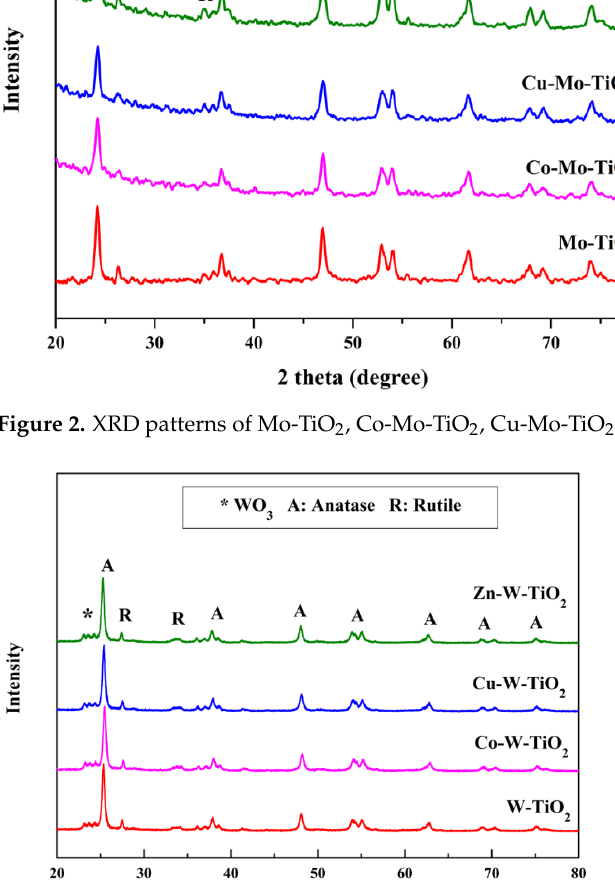
Figure 3. XRD patterns of W ‐ TiO 2 , Co ‐ W ‐ TiO 2 , Cu ‐ W ‐ TiO 2 , and Zn ‐ W ‐ TiO 2 .